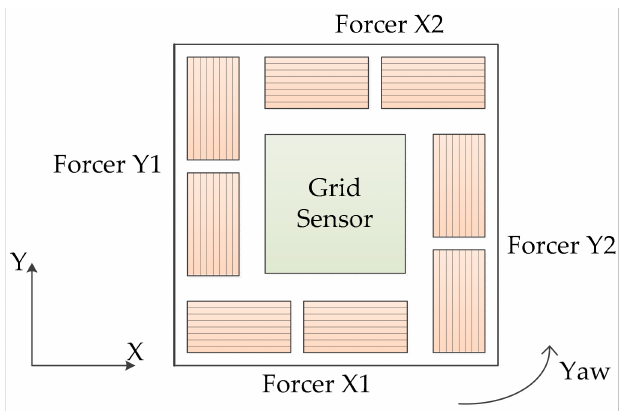
Figure 1. Bottom view of a Sawyer